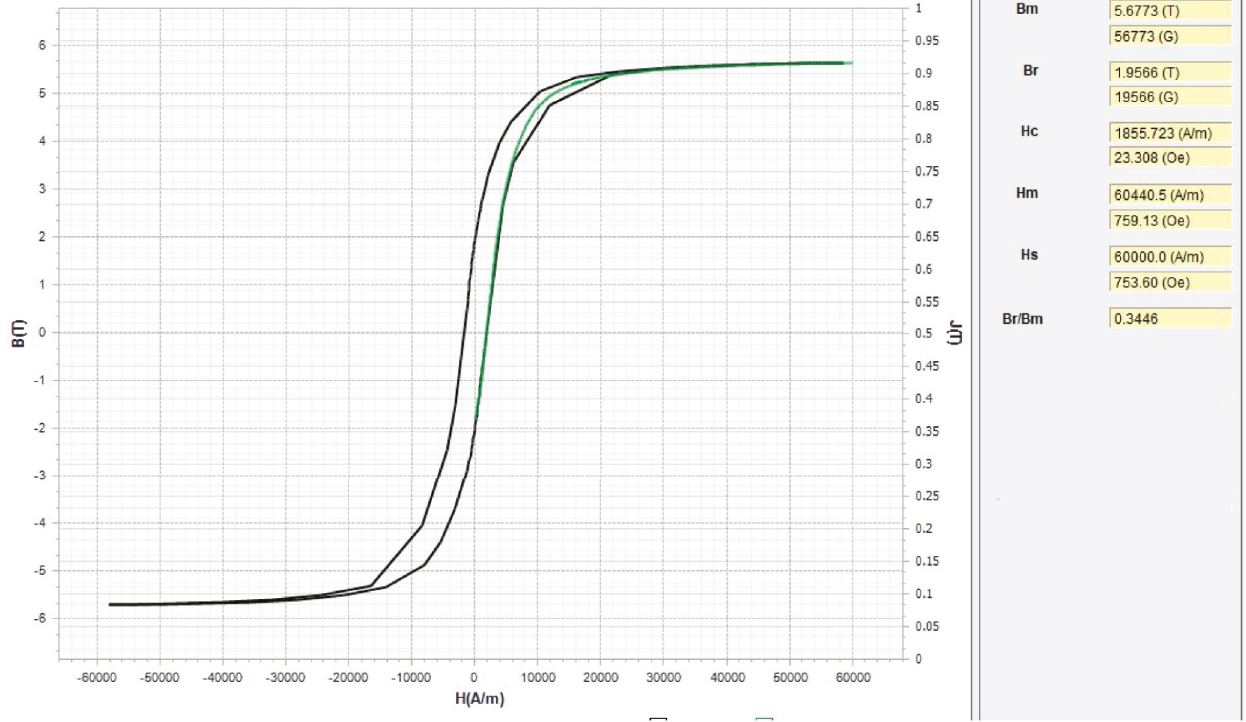
Figure 9: Measurement results of hysteresis